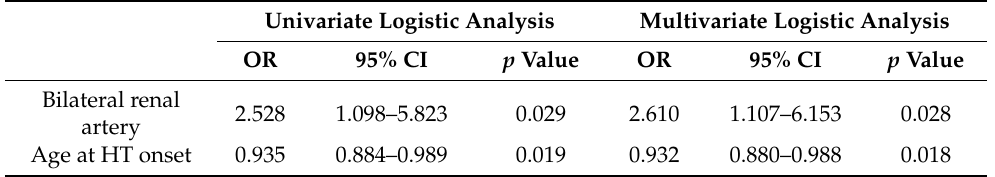
Figure 4. Least absolute shrinkage and selection operator (LASSO) analysis. ( A ) LASSO regression was used to screen the prognostic factors. Coefficients of the determined characteristics are exhibited via lambda parameters. ( B ) Cross-validation indicated that two factors (bilateral renal artery and age at hypertension onset) can be used in logistic regression. Table 4. Prognostic factors for adverse outcome under univariate and multivariate logistic analyses.